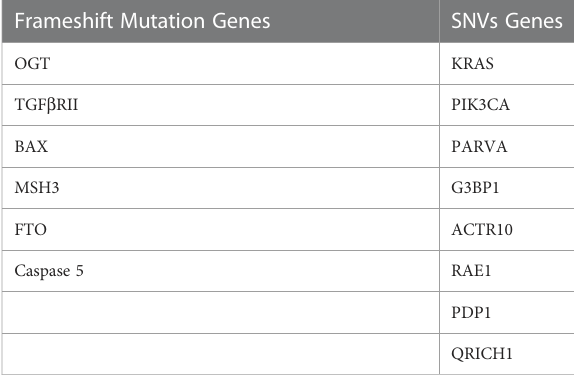
TABLE 4 List of mutated antigens found in CRC. Frameshift Mutation